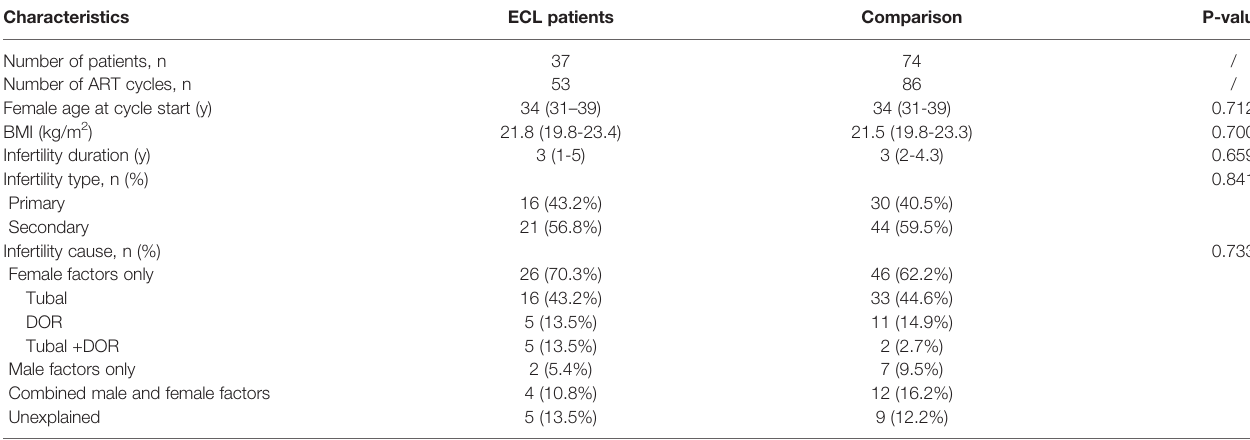
TABLE 1 | Demographic characteristics of the ECL and comparison